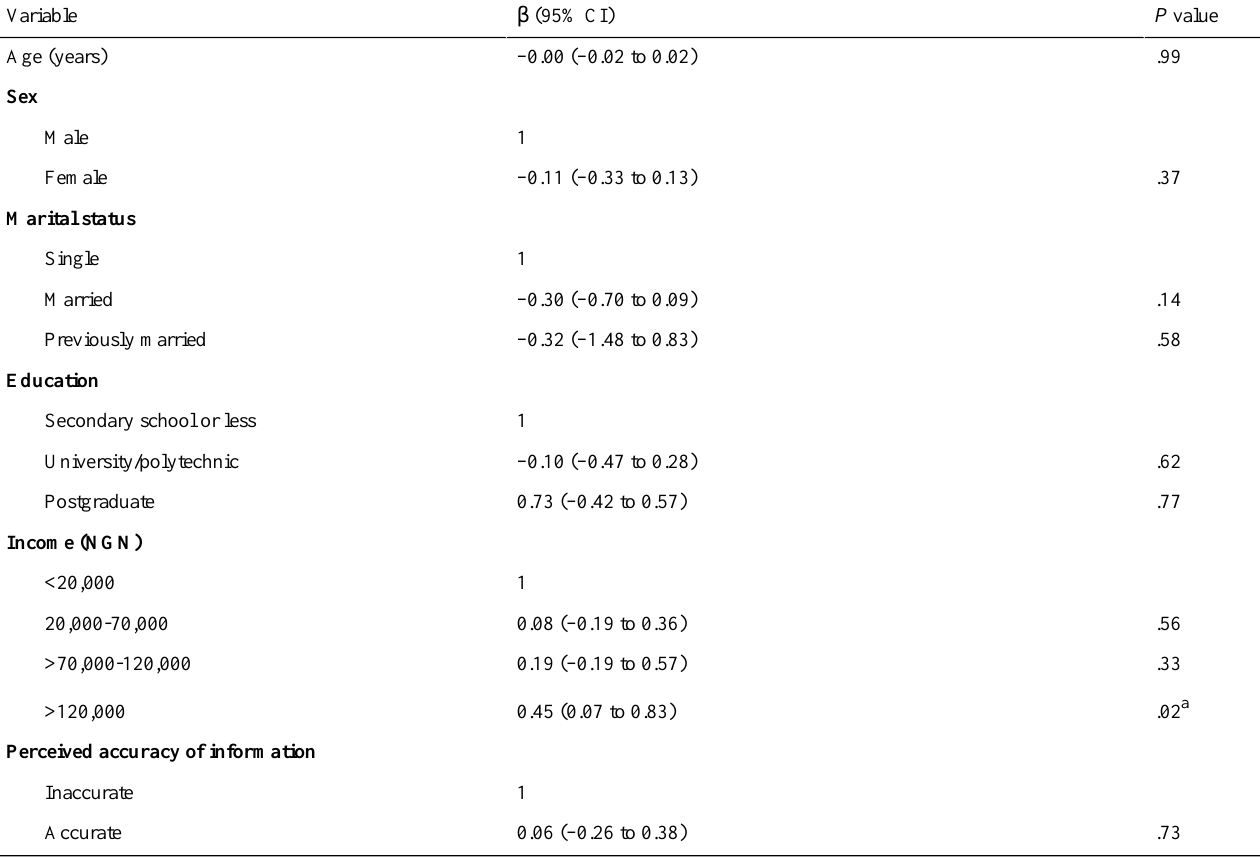
Table 2. Association between sociodemographic factors and the number of information sources using a multiple linear regression